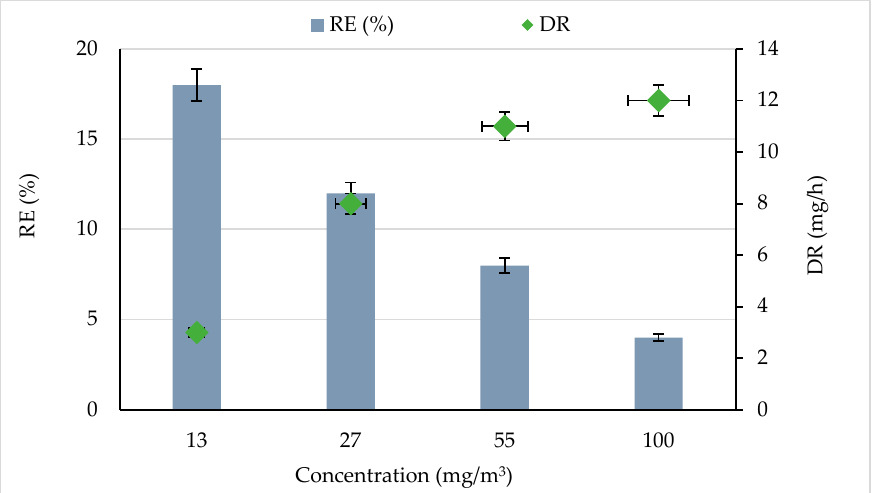
Figure 1. Effect of CB concentration on removal efficiency and degradation rate. Experimental conditions were RH = 5%, Temperature = 20 °C, and total flow rate = 0.25 m 3 /h.